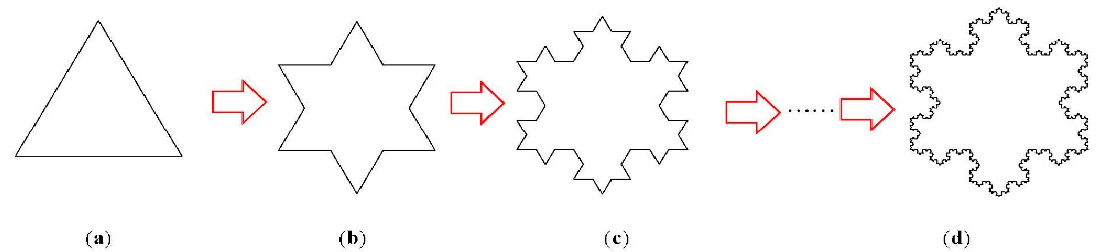
Figure 10. Koch snowflake construction process. ( a ) Initial element, ( b ) 1st construction, ( c ) 2nd construction, ( d ) 6th construction.